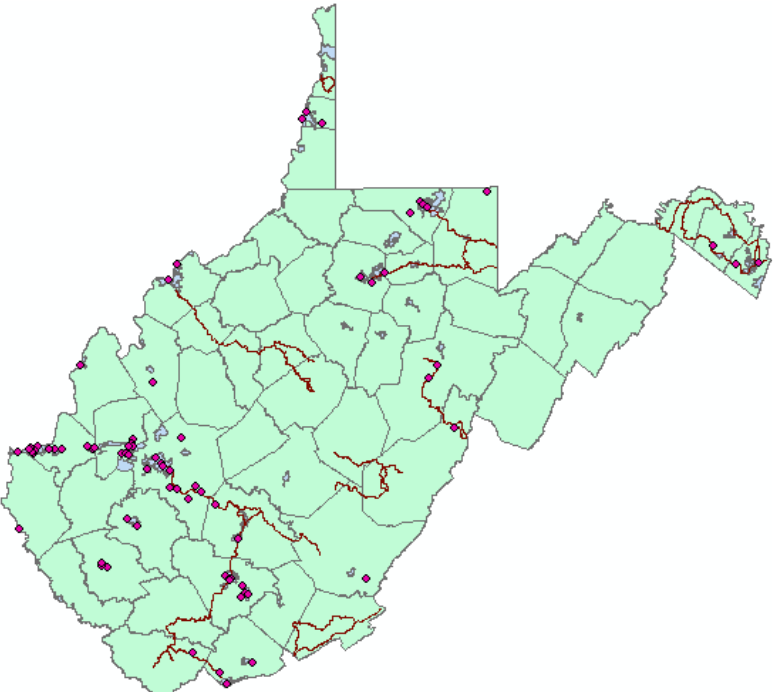
Figure A3. Map of female pedestrian fatalities in WV, 2009–2019. Burgundy lines represent major roadways. Pink diamonds represent individual crashes. Blue-grey areas represent designated towns or cities.